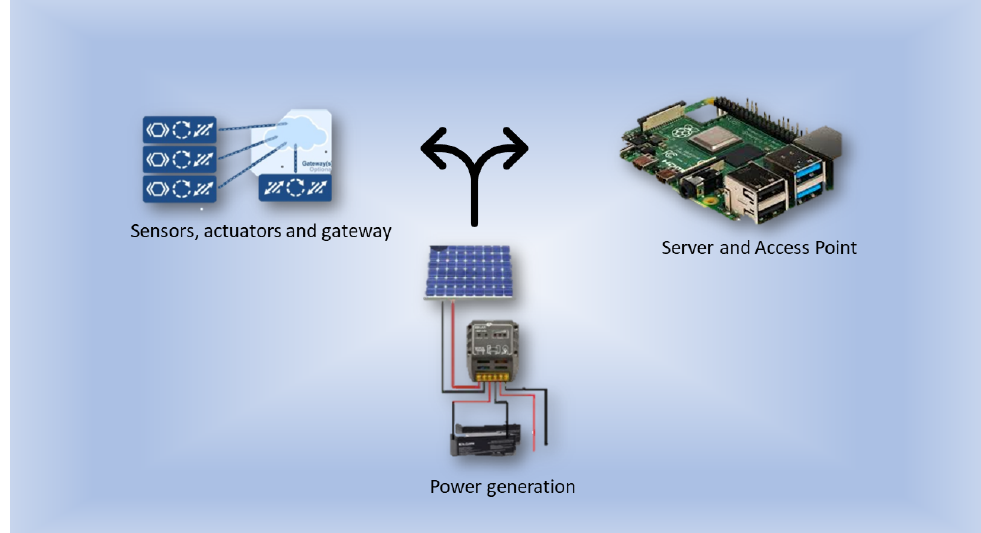
Figure 1. Off-grid